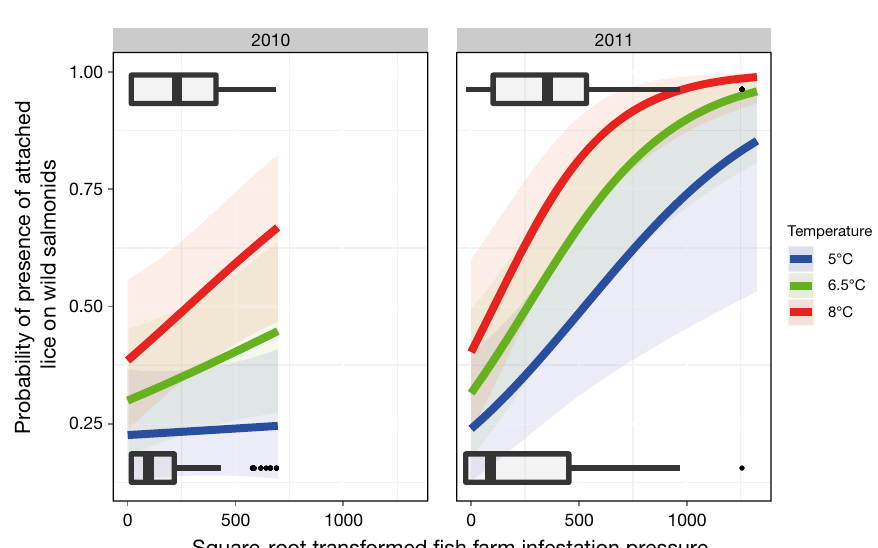
Fig. 2. Probability of presence of attached salmon lice on wild salmonids plotted versus infestation pressure imposed by nearby farms (<30 km) at 3 different temperature values, as predicted by the binary part of the zero-altered negative binominal generalized linear mixed model. Fish farm pressure is expressed as the total number of female lice on nearby farms, linearly corrected by distance as explained in Serra-Llinares et al. (2014). Boxplots show observed data: upper boxes represent fish farm infestation pressure values (square-root transformed) for fish with one or more attached lice; lower boxes infestation pressure values (square-root transformed) for fish with no attached lice. Dark horizontal lines represent median values, boxes the 25th and 75th percentiles, whiskers extreme values and black dots